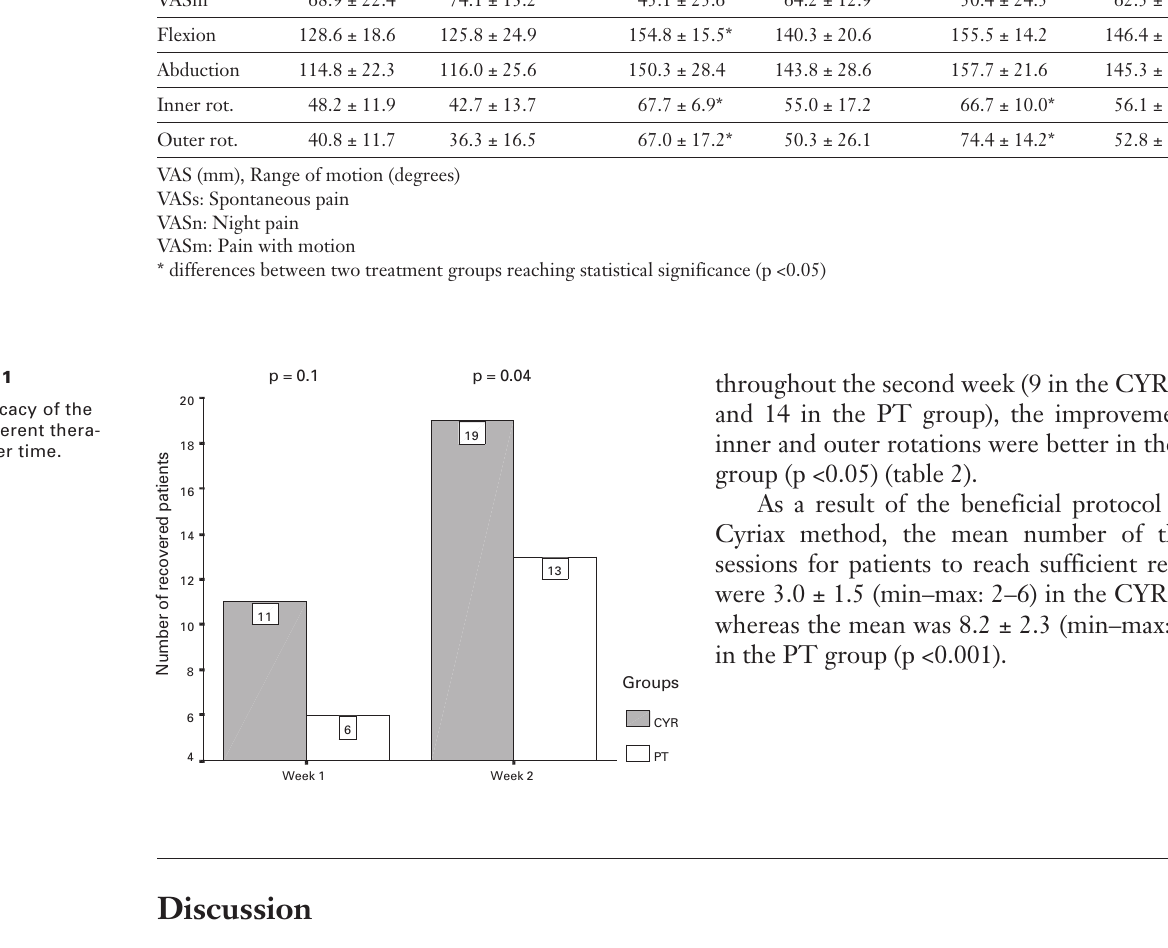
Pain and passive ROM values at the beginning and after the first and second weeks of therapy.